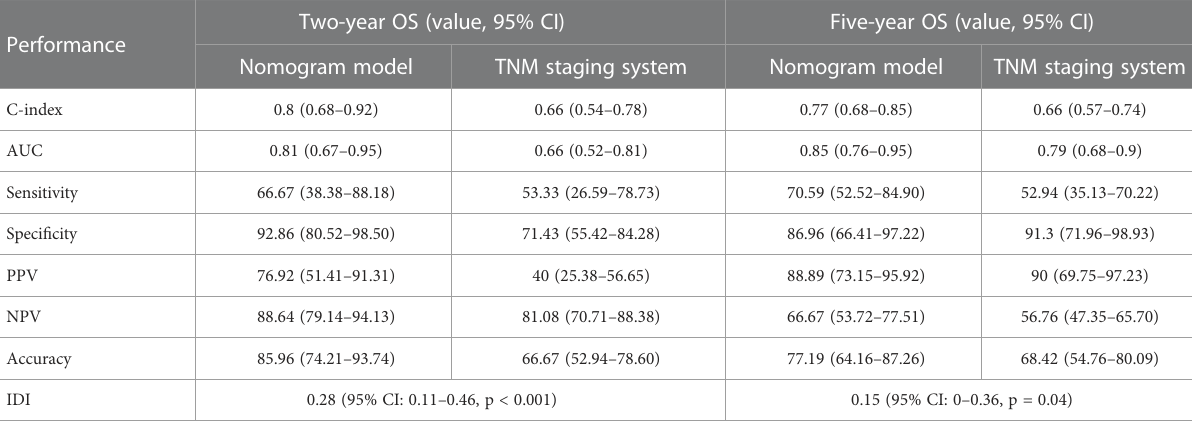
TABLE 4 Comparison of performance between the nomogram model and the TNM staging system in predicting OS of ESCC patients.